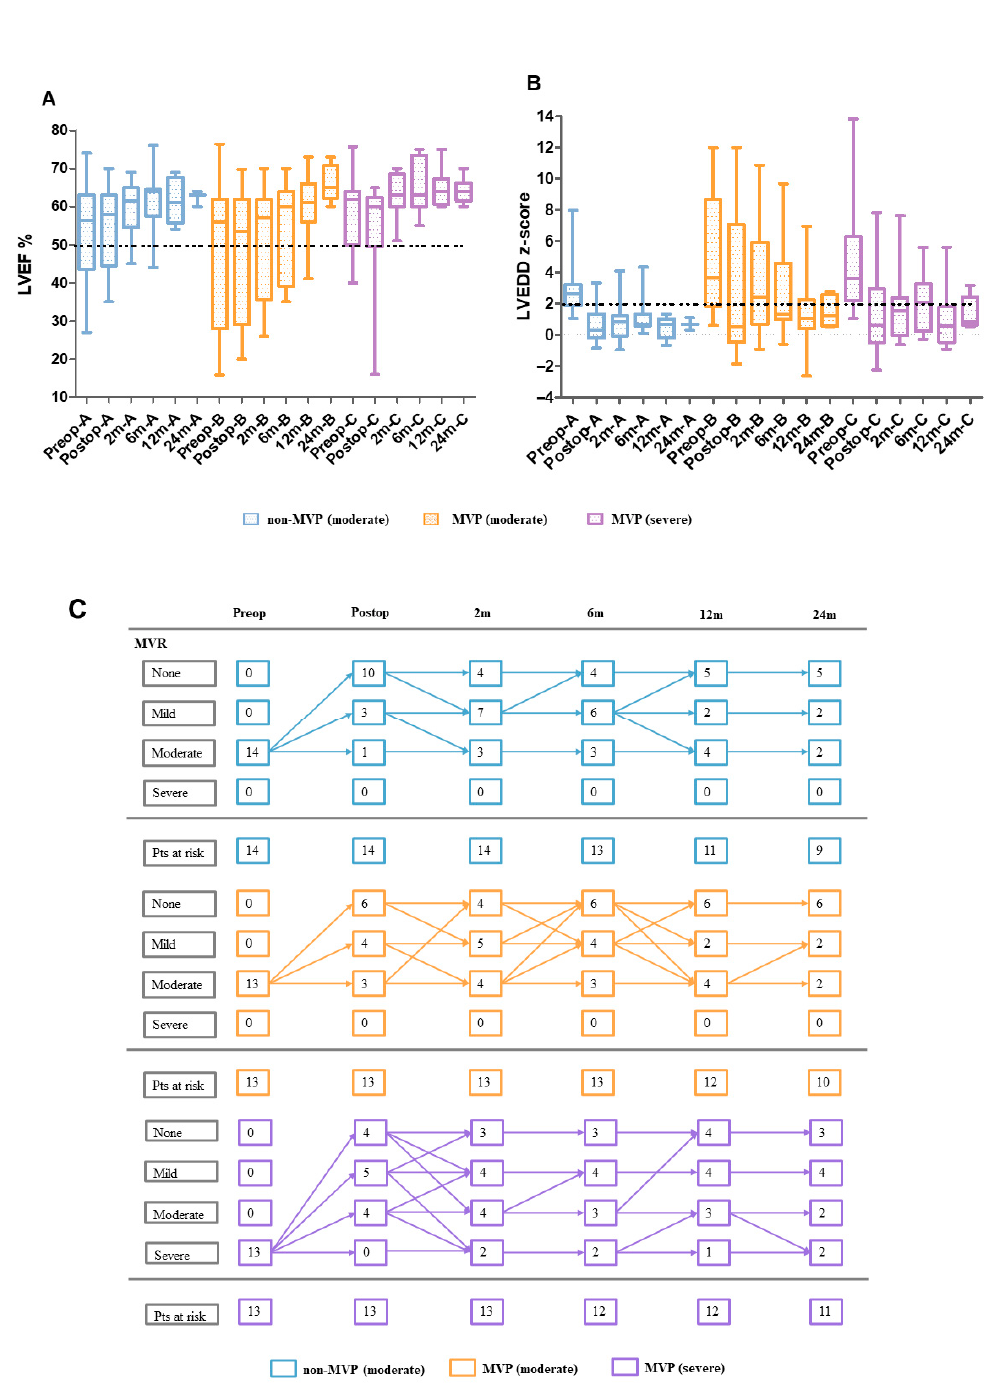
z-score returned to normal in 9/10 patients at 24 m follow-up; two (20.0%) patients had